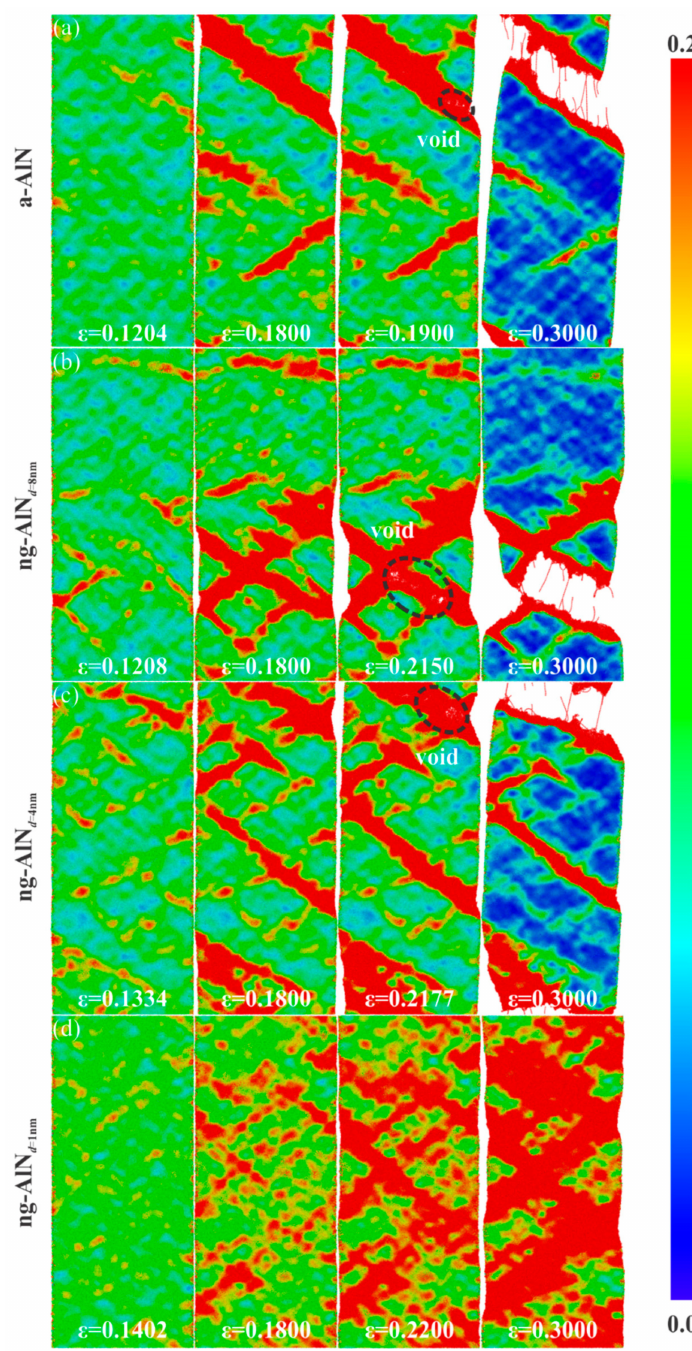
Figure 4. Evolution of von-Mises strain for ( a ) a-AlN, ( b ) ng-AlN d = 8 nm , ( c ) ng-AlN d = 4 nm , ( d ) ng-AlN d = 1 nm at di ff erent strain